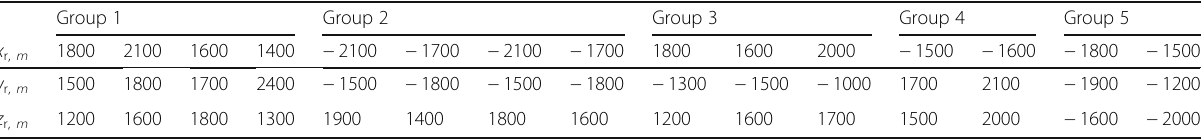
Table 3 Sensor positions in the unit of meters Group